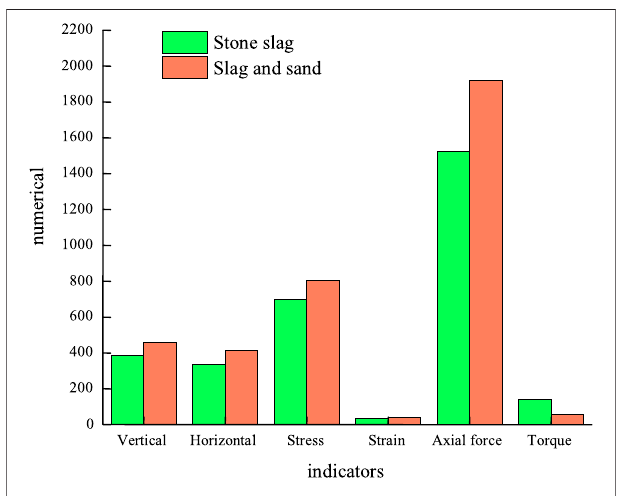
FIGURE 15 | Comparison chart of each index of the two